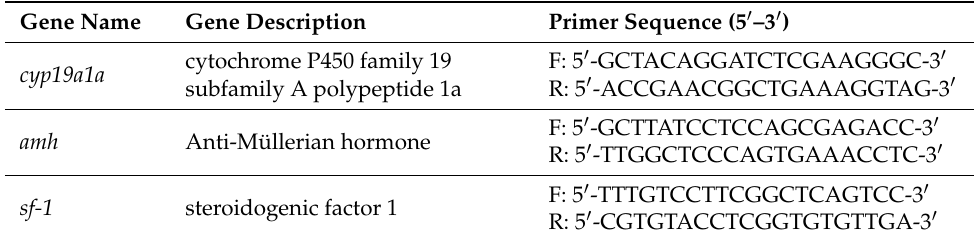
Table 1. Sequences of primers used for